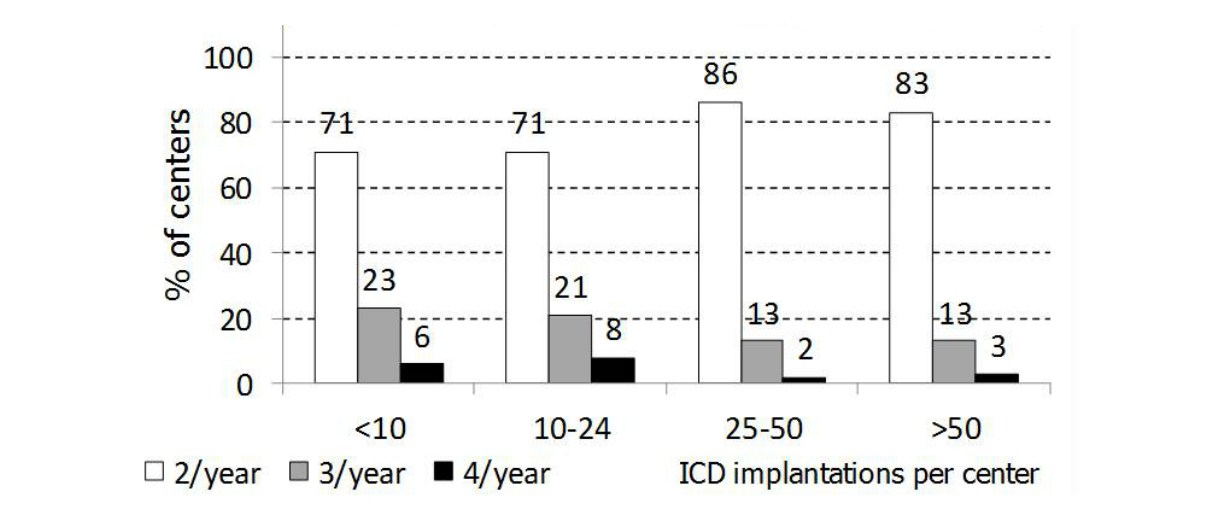
Figure 2. Frequency of scheduled in-clinic follow-up visits in relation to ICD implantation